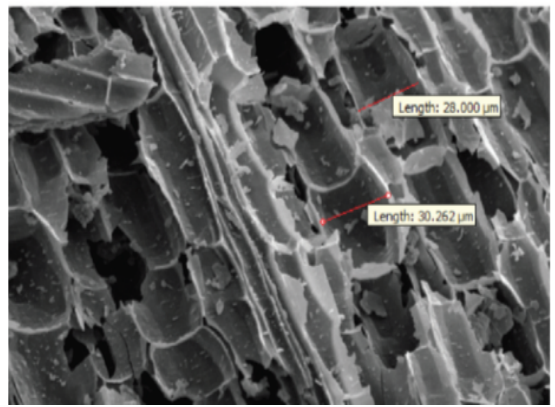
Figure 2. Scanning Electron Microscopy (SEM) Images of CW biochar [29]